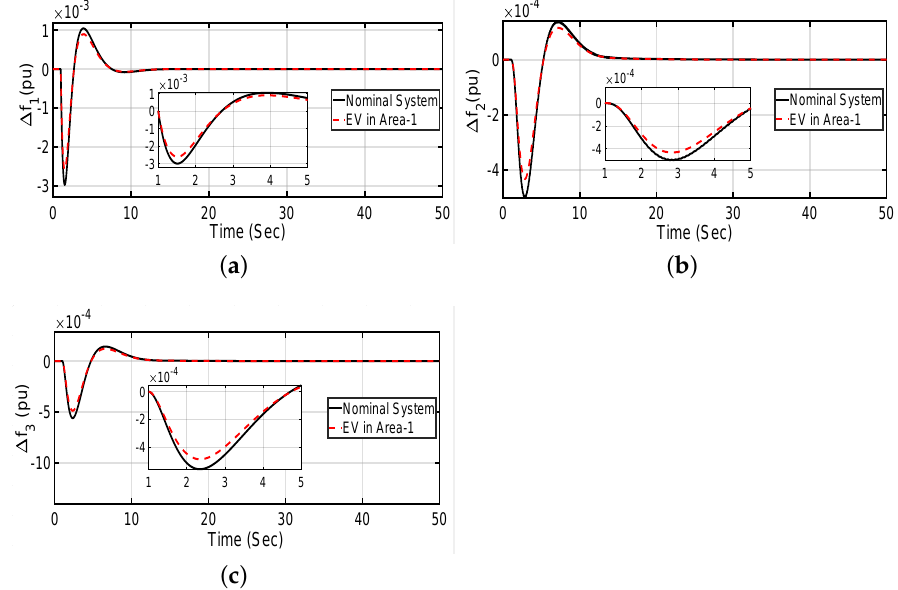
Figure 8. Response comparison when EVs are connected in Area 1 only. ( a ) ∆ f 1 ; ( b ) ∆ f 2 ; ( c ) ∆ f 3 .